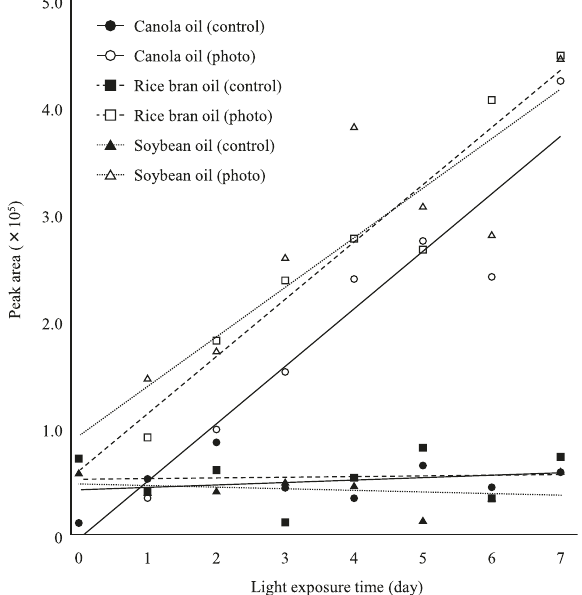
Fig. 6 Acceleration of acrolein generation in edible oils by photo irradiation. Photo-irradiated (5000 lux for 0 – 7 days) edible oils were